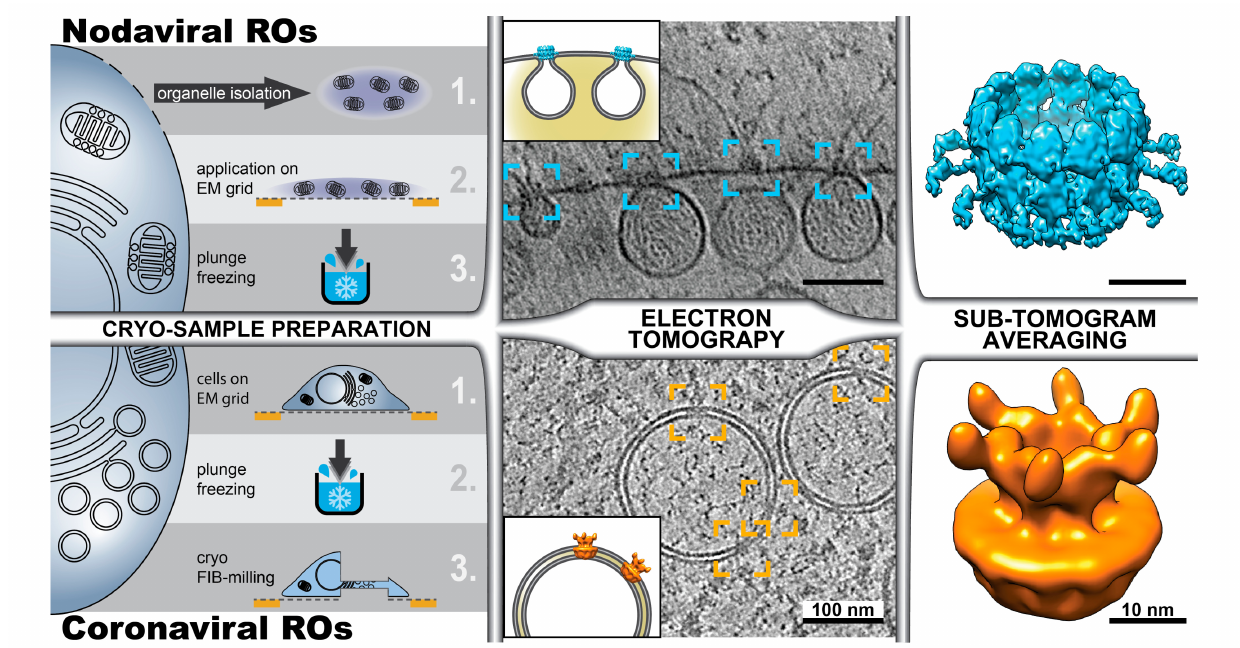
Figure 5. Cryotomography of viral ROs. Different possible workflows are exemplified with the recent cryotomography studies of the ROs induced by ( top ) nodaviruses (FHV) [70,71] and ( bottom ) coronaviruses (MHV) [72]. ( Left ) Cryotomog- raphy of subcellular structures can be performed on ( top ) plunge-frozen structures extracted from the cell or ( bottom ) on intact cells. The latter approach, known as in situ cryotomography or cellular cryotomography, requires the thinning of frozen cells, which can be carried out with a focused ion beam that mills away parts of the cell to create a thin cryo-lamella. Cryotomography revealed the presence of crown-like protein complexes in the necks of nodavirus-induced invaginated spherules (blue boxes) and spanning the two membranes of coronavirus-induced DMVs (orange boxes) (tomographic slices adapted from [70] and [72], respectively). For sub-tomogram averaging, hundreds to thousands of sub-volumes containing these crown-shaped complexes were extracted from the cryotomograms, aligned in 3D, and averaged. Following this approach, the structure of the FHV spherule crown complex was resolved at 8.5 Å resolution (top, surface rendering of the Electron Microscopy Data Bank (EMDB) entry EMD-22129, [71]), and the structure of the DMV-spanning MHV pore complex was determined at 30.5 Å (bottom, rendered from EMDB entry EMD-11514,